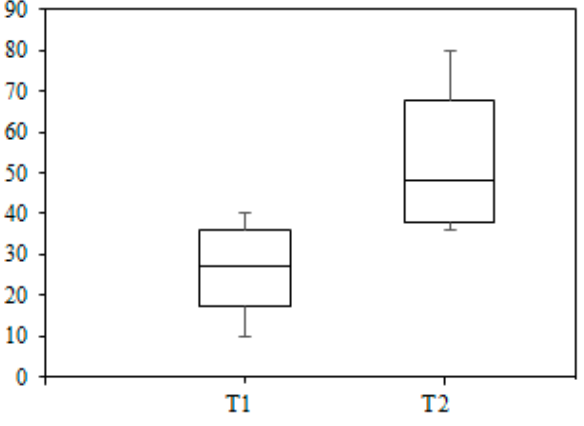
Figure 13. Boxplot for total time taken by two teams to determine Variability and Commonality.